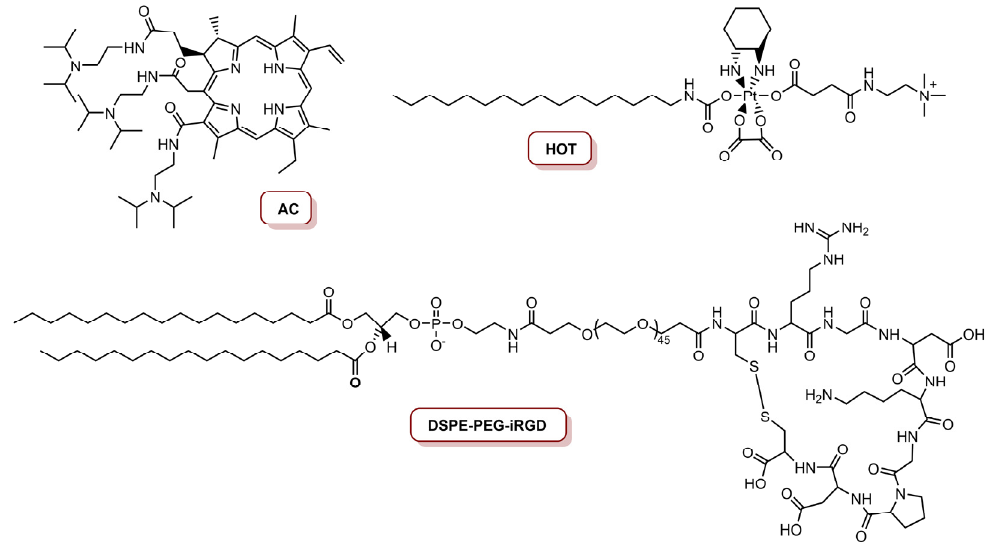
Figure 5. Structures of the acid derivative of Ce 6 (AC), HOT prodrug and iRGD-conjugated phos- pholipid